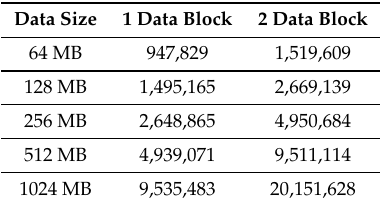
Table 3. Time of transferring different data blocks